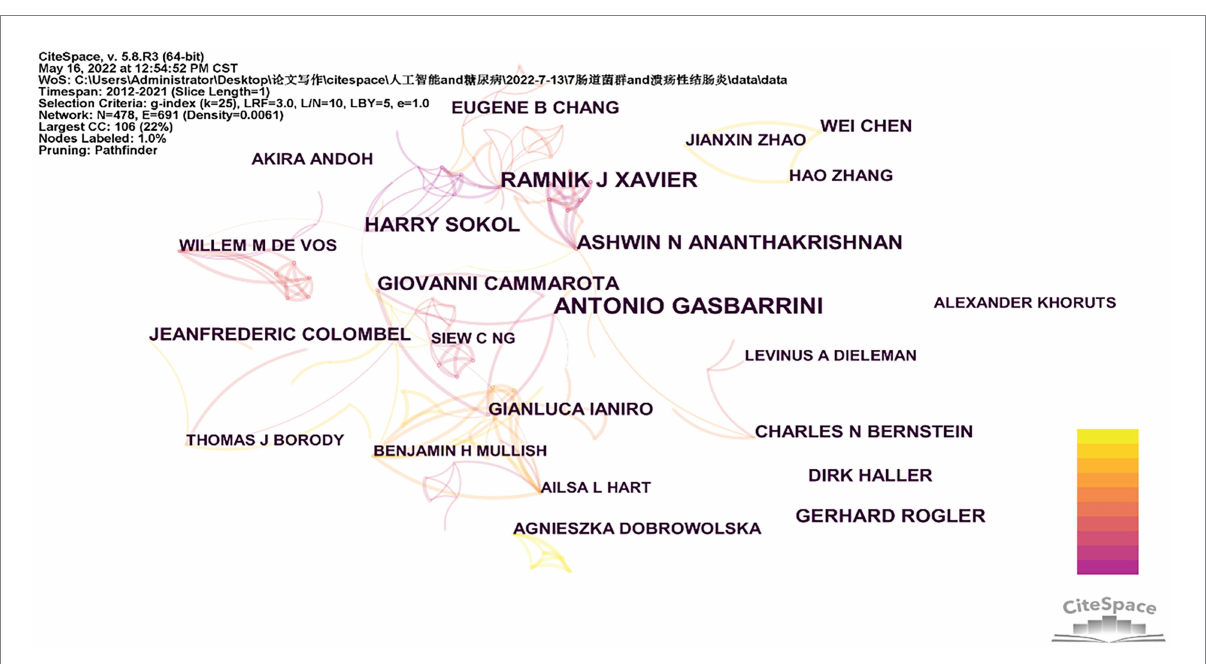
FIGURE 4 Author collaboration